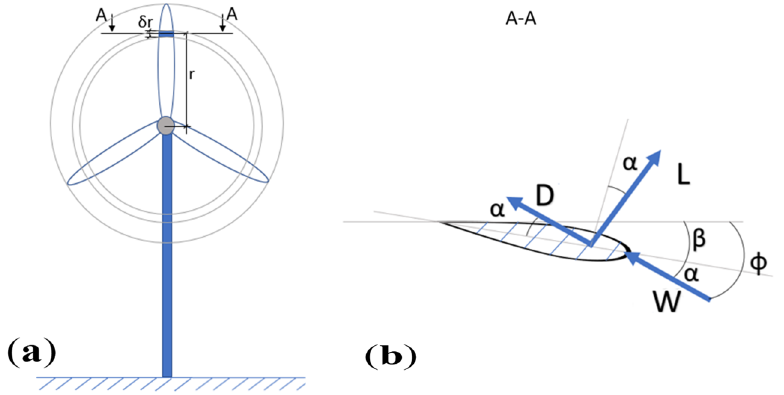
Figure 3. ( a ) Schematic representation of the blade element and ( b ) the forces acting on it.